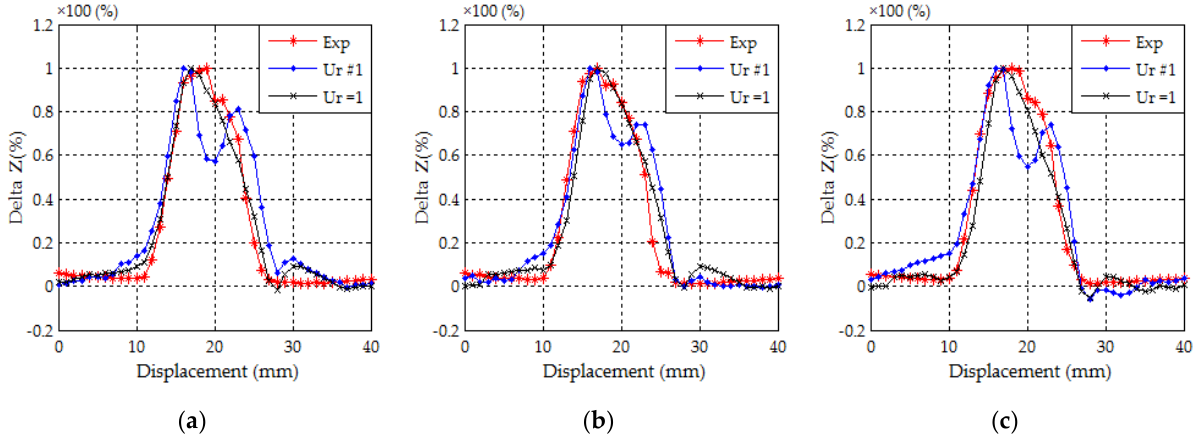
Figure 8. Impedance variation in (%) at 10 kHz with ( a ) depth = 0.3 mm, ( b ) depth = 0.5 mm, and ( c ) depth = 1 mm.